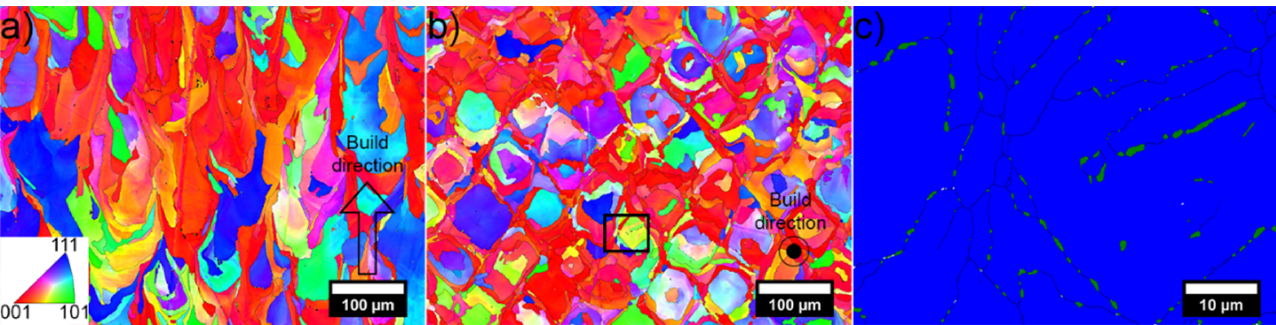
build direction is marked with an arrow in the images. ( c ) Shows EBSD phase map (ferrite in blue